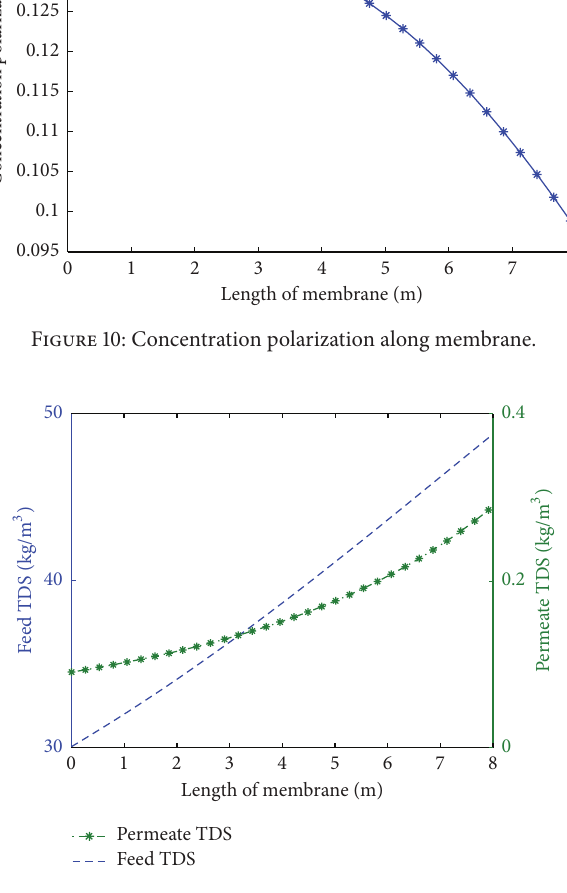
Figure 11: Values of feed TDS and permeate TDS along membrane.